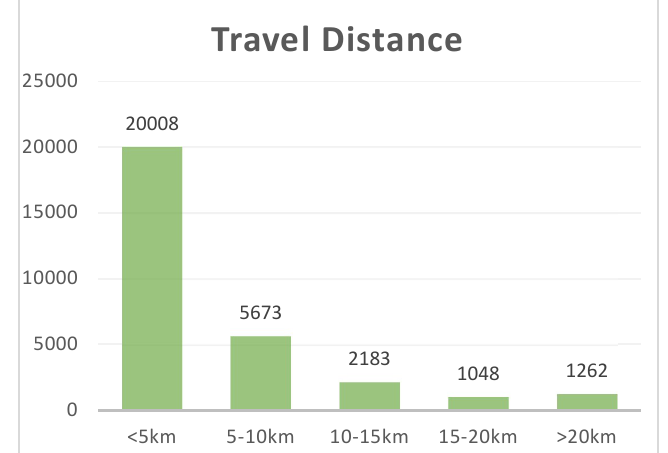
Figure 2. Wuhan commuting travel distance distribution.